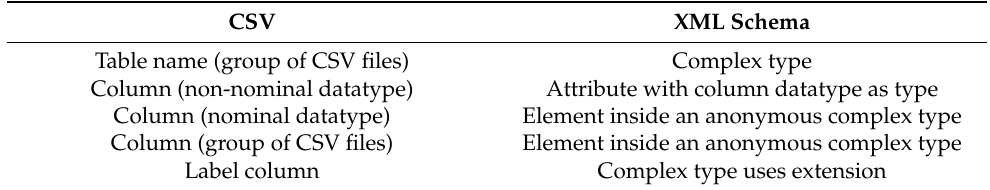
Table 2. CSV to XML schema mapping rules. Table name (group of CSV